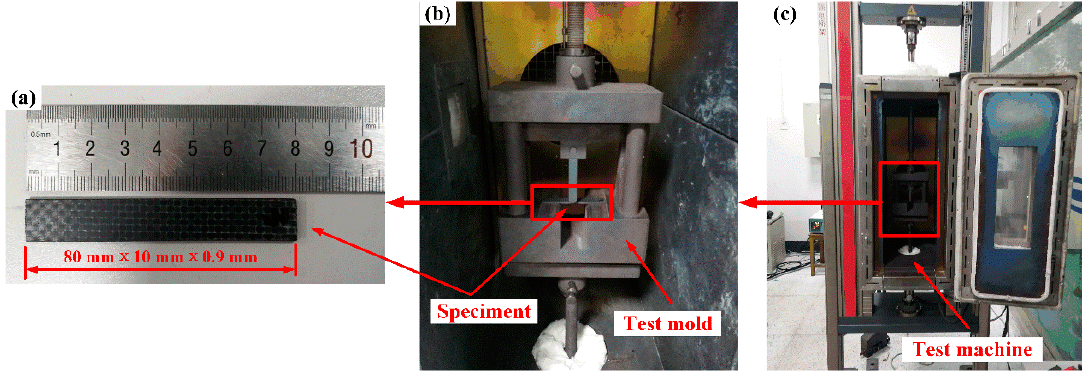
Figure 2. Representation of Flexural test at elevated temperatures: ( a ) Specimens; ( b ) test mold; and ( c ) test equipment.